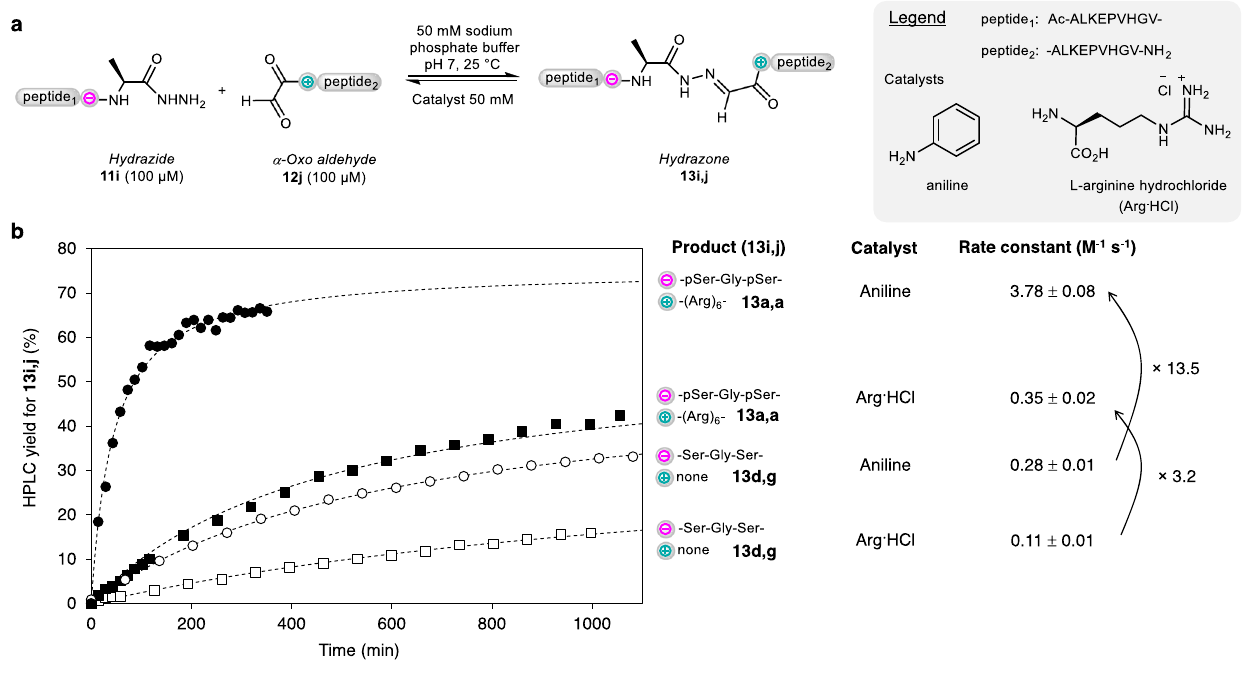
Fig. 5 | Electrostatic assistance of hydrazone ligation. a Principle. b kinetic data and fi tting curves (dashed lines) of hydrazone ligations conducted in the presence of arginine hydrochloride (Arg ∙ HCl) or aniline as nucleophilic catalysts. The